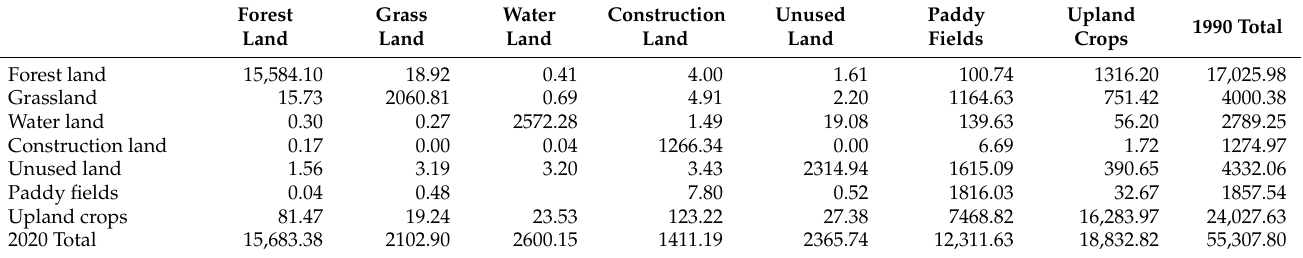
Table 4. Areas of land use transformation among the land types of forest land, grass land, water land, construction land, unused land, paddy fields and upland crops from 1990 to 2020 (unit: km 2 ). Forest Grass Land